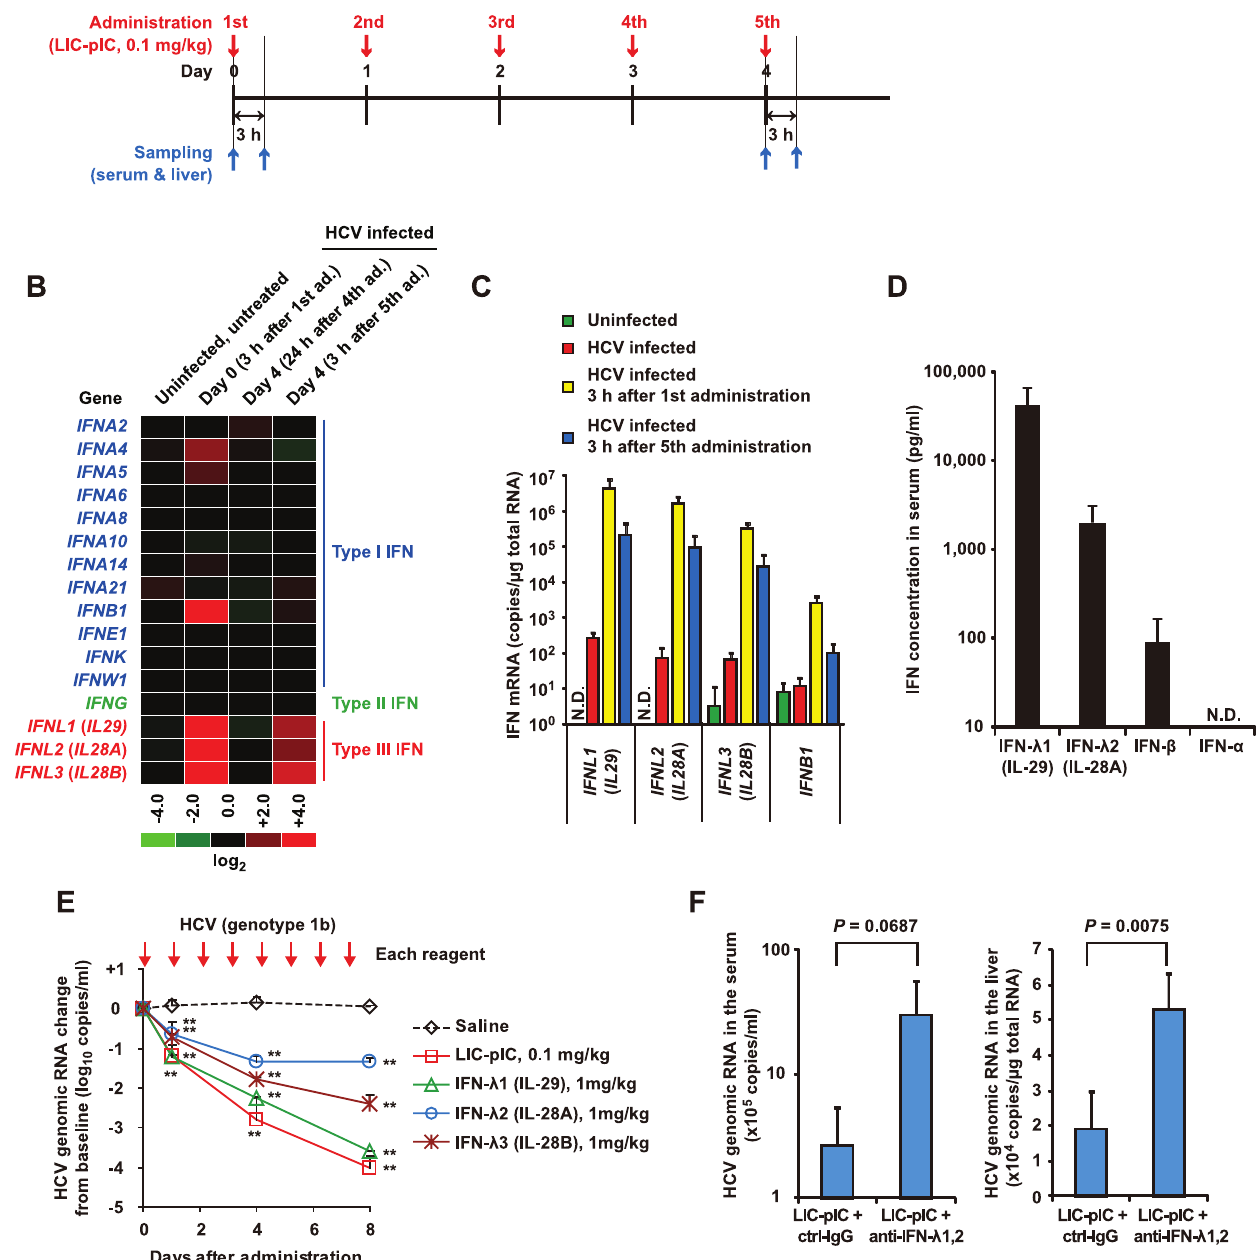
Figure 3. IFN expression following induction of innate immunity by LIC-pIC. ( A ) Experimental schedule in the chimeric mice infected with HCV. ( B ) Microarray analysis of IFN family gene expression. Log 2 ratio values of gene expression were calculated with respect to control (untreated and HCV-infected) chimeric mice . ( C ) Liver mRNA levels of human IFN genes ( n =3–5 per group), as determined by qRT-PCR. ( D ) Serum concentration of human IFN- l 1, IFN- l 2, IFN- b , and IFN- a ( n =3 per group), as determined by ELISA. ( E ) Serum HCV RNA levels, relative to the baseline, in HCV- infected chimeric mice treated with human IFN- l , LIC-pIC, or control saline ( n =3–5 per group), as determined by qRT-PCR. ( F ) The HCV RNA levels in the serum and liver of HCV genotype 1a-infected chimeric mice collected on Day 4 of LIC-pIC treatment, as determined by qRT-PCR. The mice were additionally treated with either a control antibody or a neutralizing antibody against IFN- l ( n =3 per group). Bars indicate SD. ** P , 0.01, treatments vs. saline controls on the respective day, by Dunnett’s multiple comparison test. encoding genes at high levels, while expression of the IFN- from the same livers. Thus, human hepatocytes (in contrast to b receptor-encoding genes remained low. In contrast, expression mouse hepatocytes) are rich sources of IFN- l s, while IFN- a or of the IFN- l receptor-encoding genes was low and expression of IFN- b are produced at lower levels in these cells. Indeed, the expression (in humanized livers) of these IFN- l -encoding genes the IFN- b receptor-encoding genes was high in mouse hepatocytes